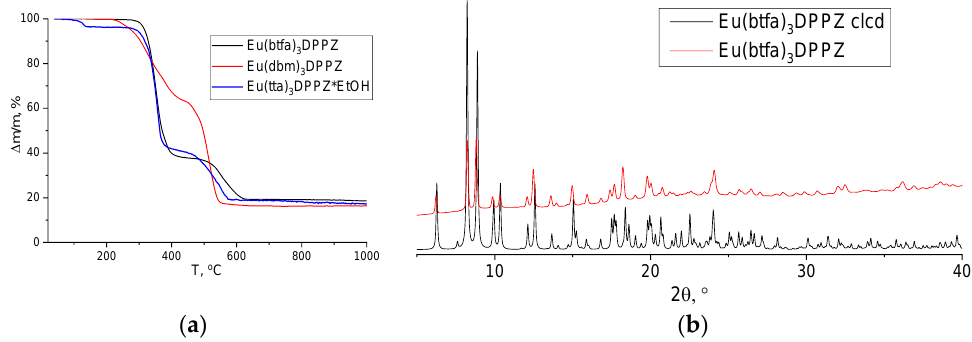
Figure 2. ( a ) TGA data of Eu(btfa) 3 DPPZ, Eu(tta) 3 DPPZ·EtOH, and Eu(dbm) 3 DPPZ powders and ( b ) PXRD patterns for Eu(btfa) 3 DPPZ: experimental (red curve) and calculated from the crystal structure (black curve).